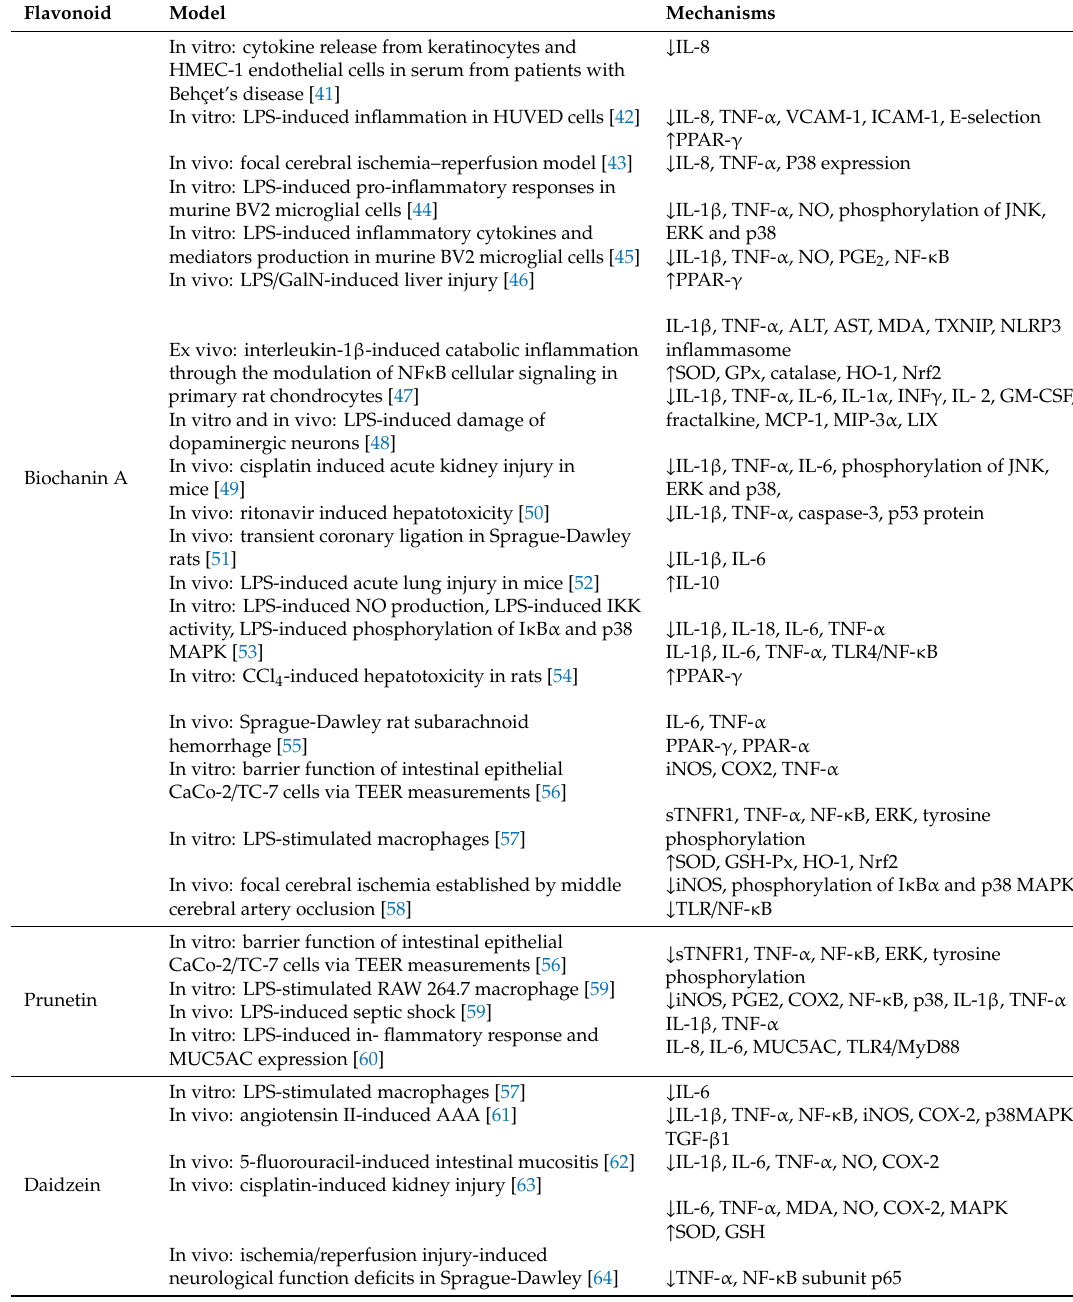
Table 4. Anti-inflammatory e ff ects of the selected